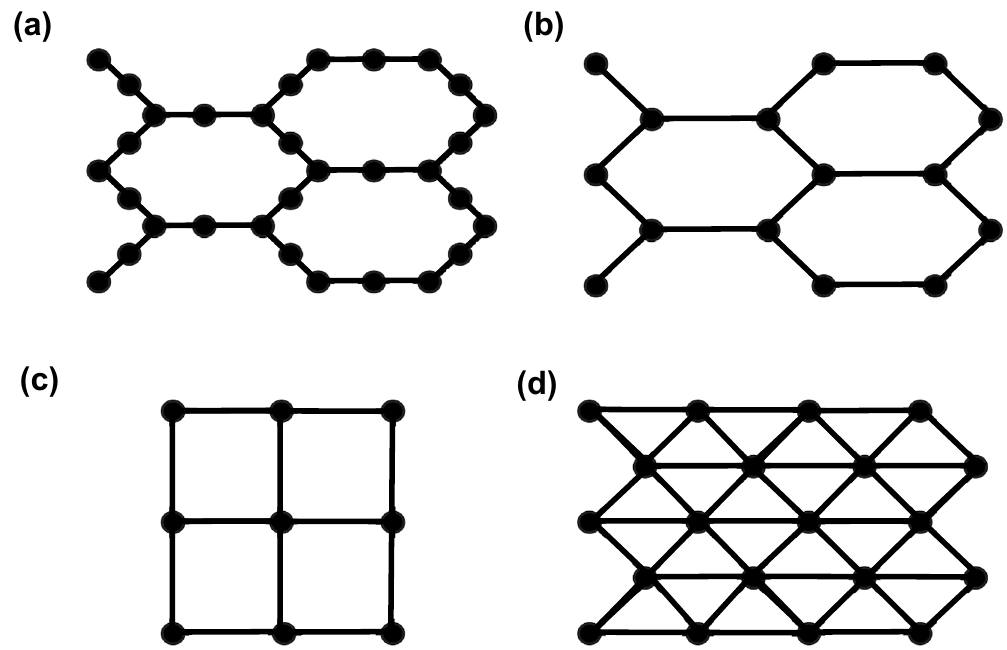
2.5 ( b ) hexagon, d H =